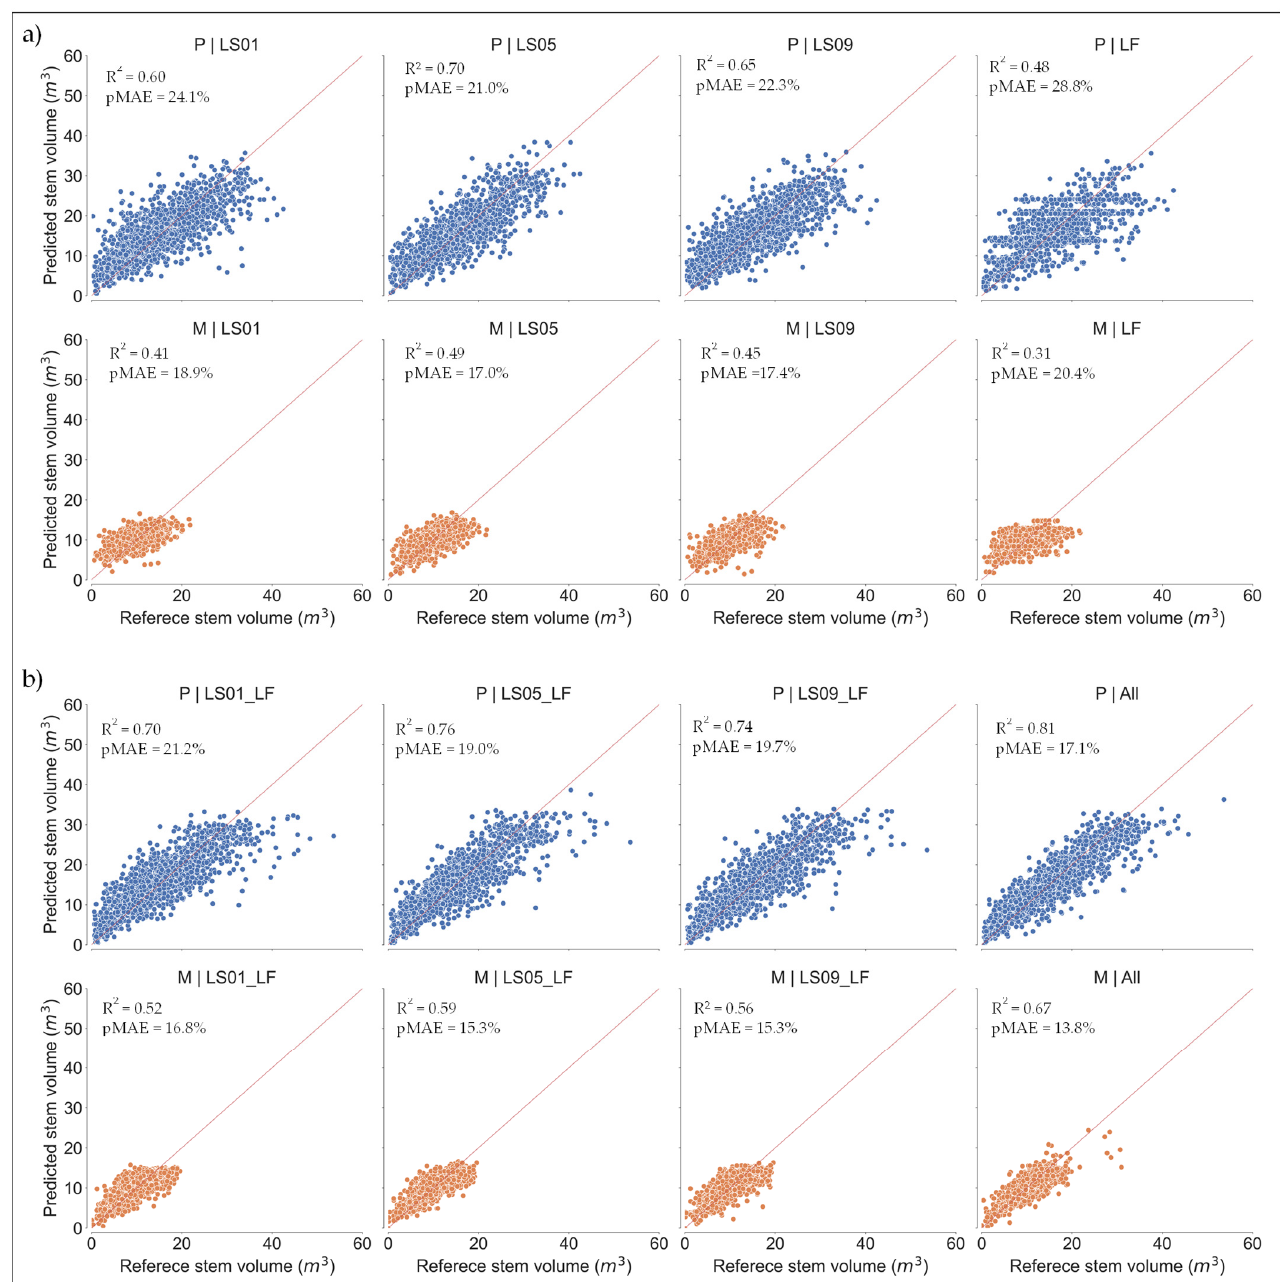
Figure 5. Predicted vs. reference stem volume per pixel in cubic meter: ( a ) stem volume prediction by models fit separately with Landsat (LS01 = 01/2018, LS05 = 05/2018, LS09 = 09/2018) and LANDFIRE (LF) data for pines (top row) and mixed forests (bottom row); ( b ) stem volume prediction by models fit with LANDFIRE and each Landsat (LS01_LF, LS05_LF, LS09_LF) scene and with all the data combined (All) for pines (top row) and mixed forests (bottom row). P denotes pines, M denotes mixed forests. The red dashed line indicates the expected 1:1 relationship between the two estimates.